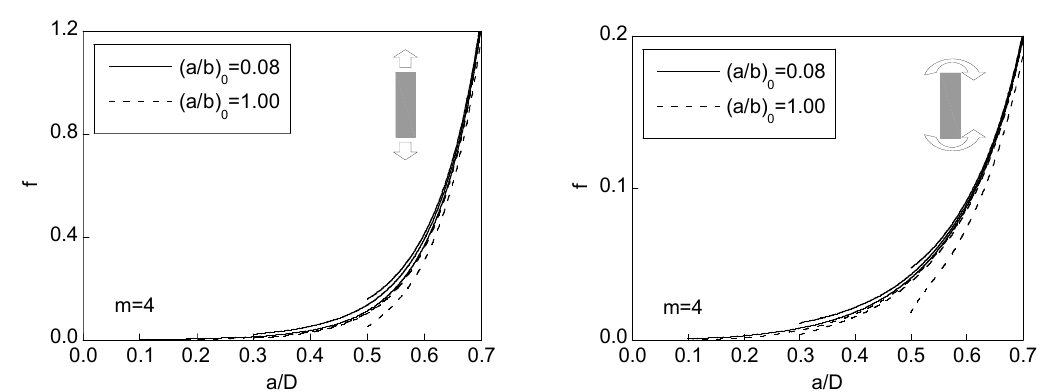
Figure 10: Evolution of the dimensionless compliance f with crack growth (represented by the relative crack depth a / D ) for m =4, starting from different initial crack geometries under tension loading (left) and bending moment